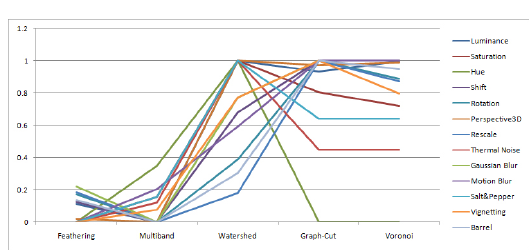
Figure 6. Distortion - Test Normalized SSIM MSE Response